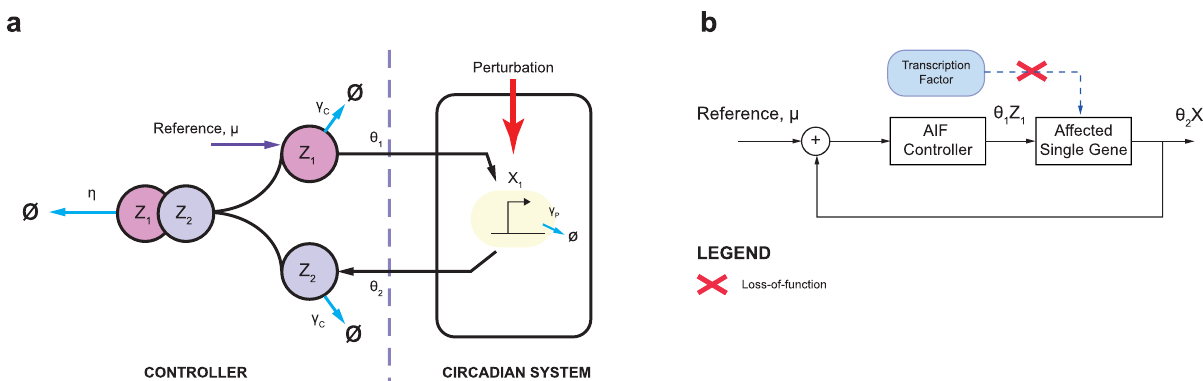
Fig. 2 The architecture of the AIF controller. a The AIF controller adapted to circadian system has two control species, Z 1 and Z 2 , where the former and the latter act as an actuator and a sensor respectively. Z 1 and Z 2 both degrade at the rate γ C . The key mechanism to achieving integral control is the sequestration of Z 1 and Z 2 at the rate η . Z 1 is a product of the reference reaction, μ , which in turn actuates the process through X 1 at the rate θ 1 , where the output gene X 1 is sensed by Z 2 at the rate θ 2 . b The closed loop con fi guration of the AIF controller in restoring transcription factor-driven production of an affected single gene in the circadian models (except JD2016), we set μ = μ min in Eq. 1. The resulting values of η are shown in the rightmost column of Table 1.